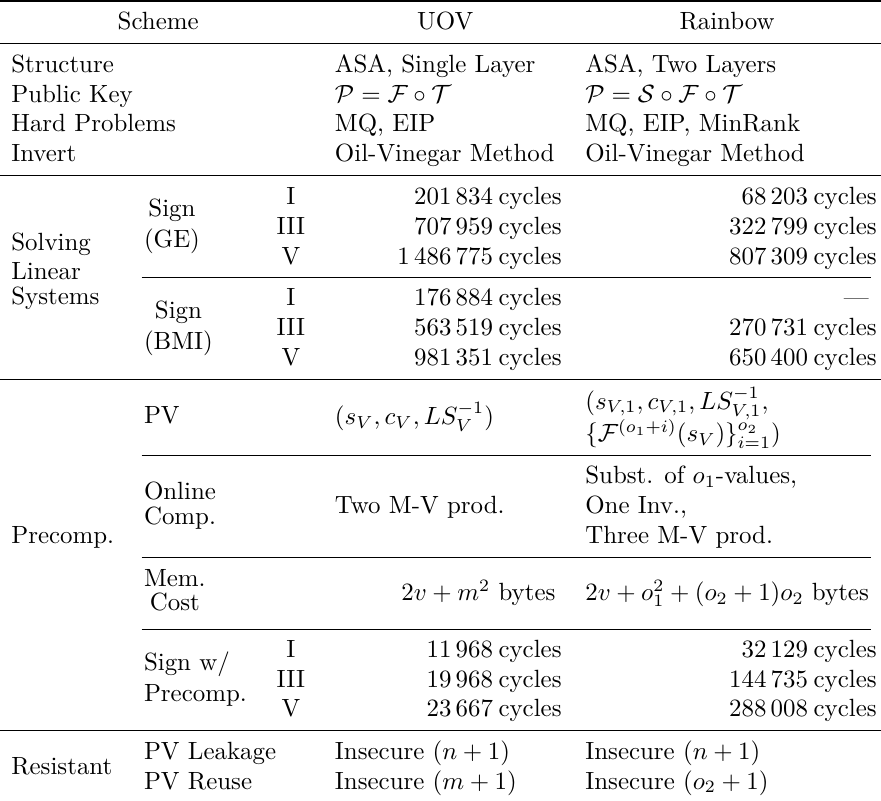
Table 7: Comparison of UOV/Rainbow with our